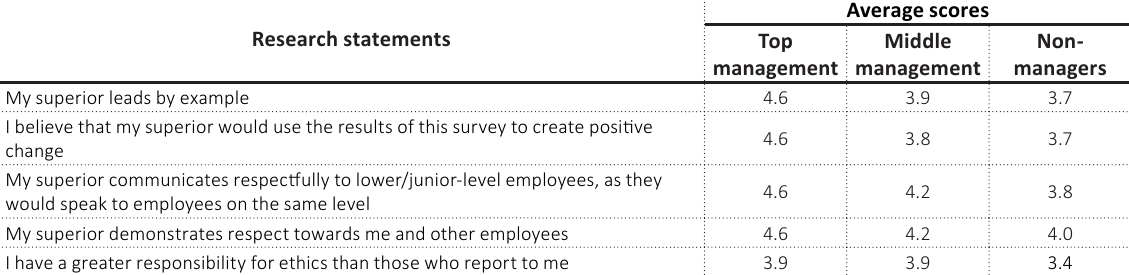
Table 1. Perception of Integrity, trustworthiness, and respect by position